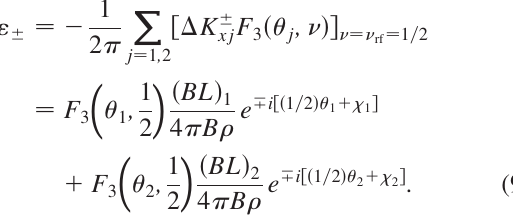
j at 100 GeV in the drift space L232 FIG. 2. (Color) Graph of j F 3 of RHIC for three scenarios: (a) solid (purple)—no rotators; (b) dashed (green)—longitudinal polarization at both STAR and PHENIX; (c) dot-dashed (red)—no rotators at STAR, radial polarization at PHENIX. The horizontal axis shows the arclength in meters, measured from the 6 o’clock point.